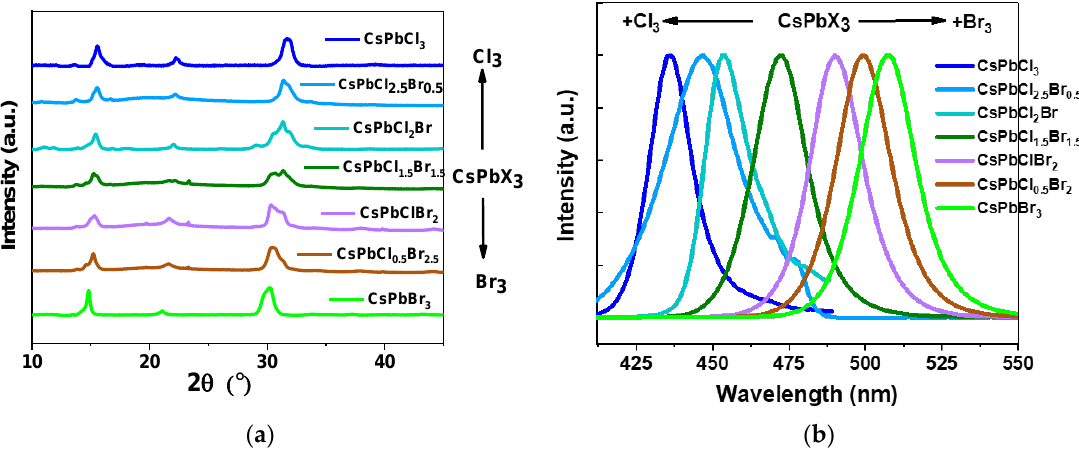
Figure 2. ( a ) X-ray diffraction patterns and ( b ) photoluminescence spectra for mixed-halide CsPbCl y Br 3 − y ( y = 0, 0.5, 1, 1.5, 2, 2.5, and 3)